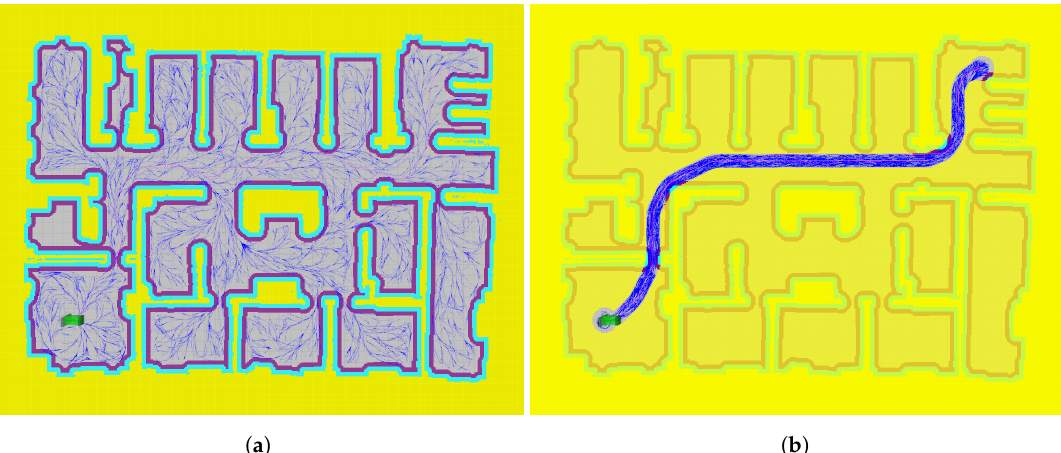
Figure 14. Path planning to travel between two corners of the map: ( a ) Path planning without mask (RRT*); ( b ) Path planning with mask (LA*-RRT*).